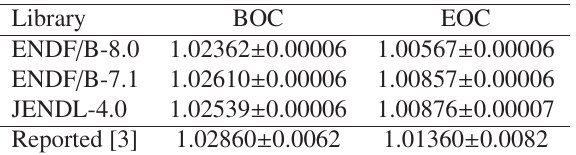
Table 2. k of oxide core at BOC and EOC